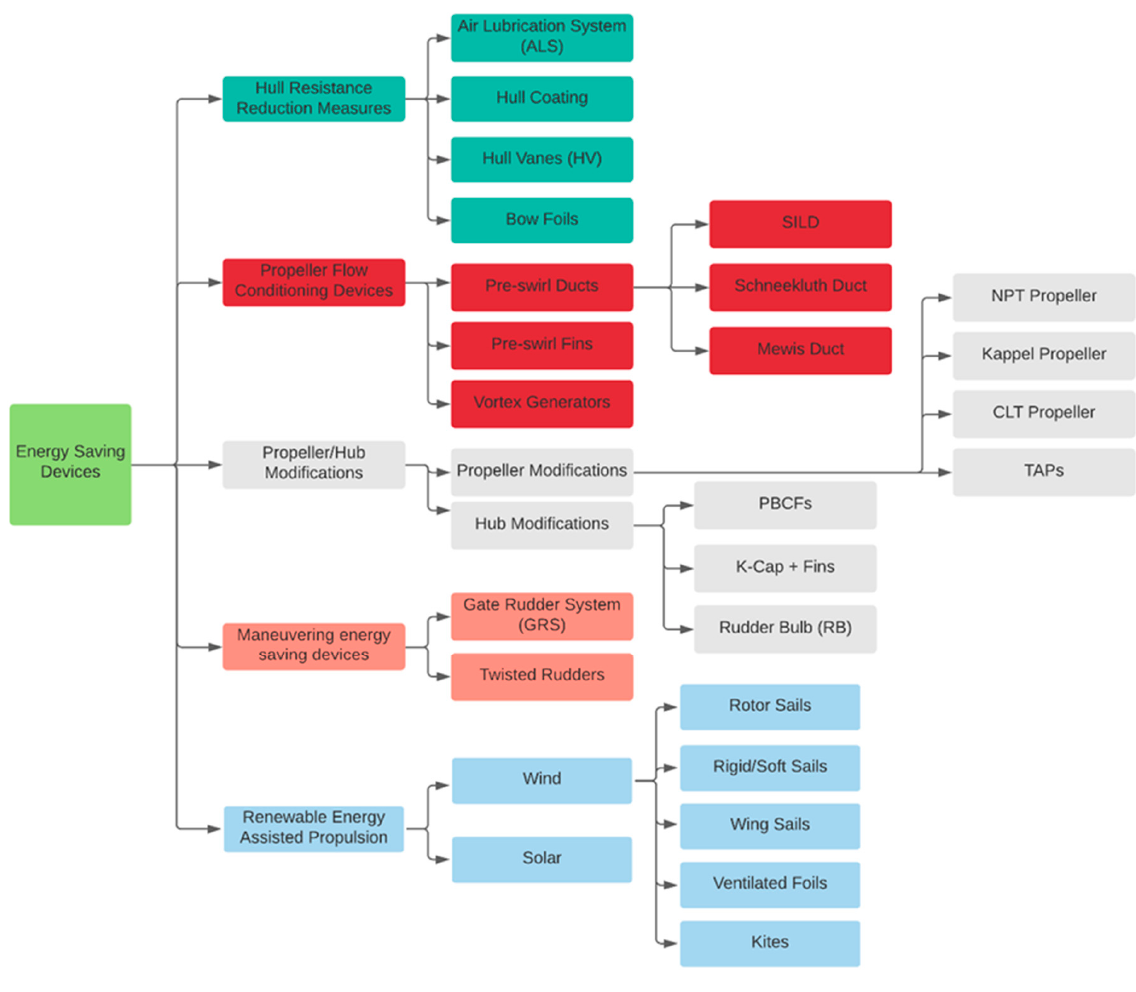
Figure 2. Categorisation of existing and emerging energy-saving devices (ESDs).